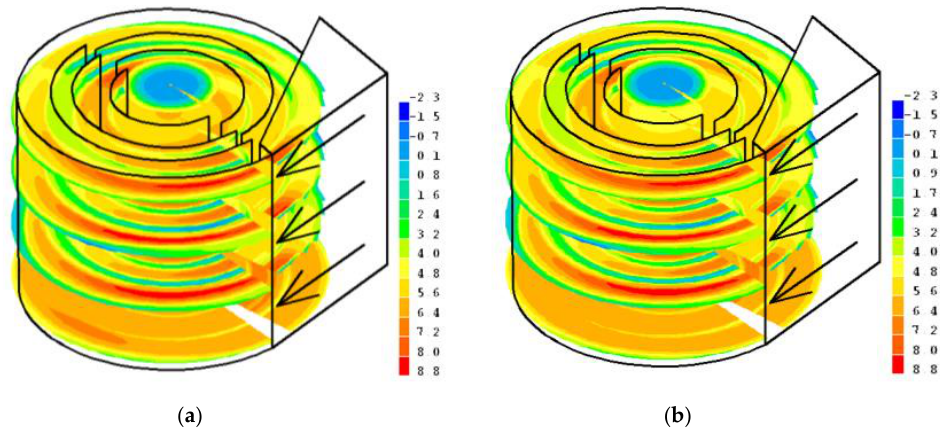
Figure 5. The gas (air) flow (first phase ( a ) and second phase ( b )) flow velocity components’ distribution in the six-channel cyclone structure using median-diameter (8.995 μm ) glass particulate matter at a 6.3 m/s inlet velocity in the cyclone.